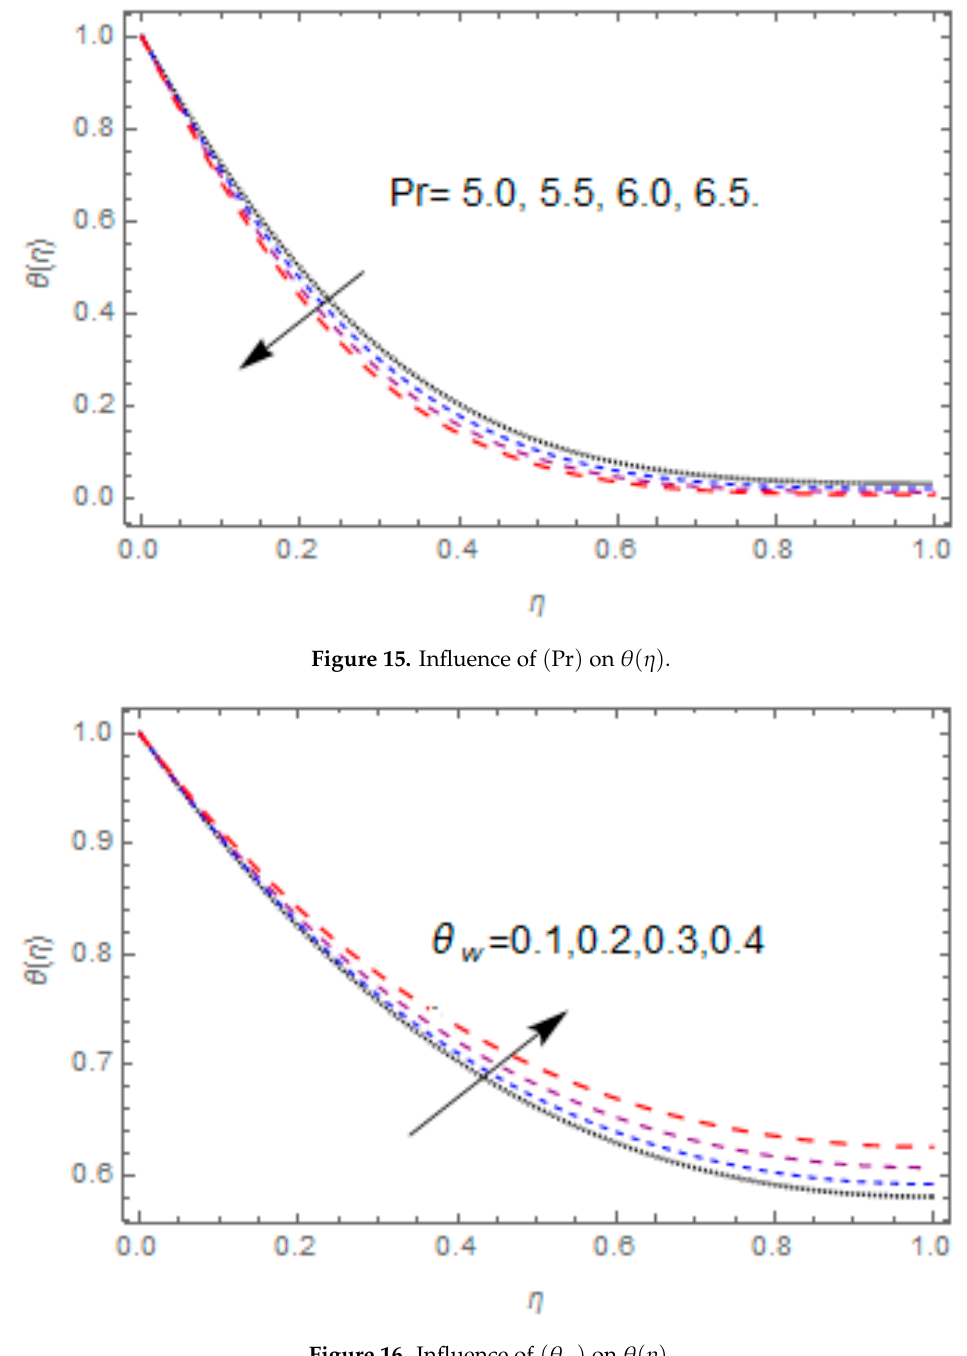
Figure 16. Influence of ( θ w ) on θ ( η )